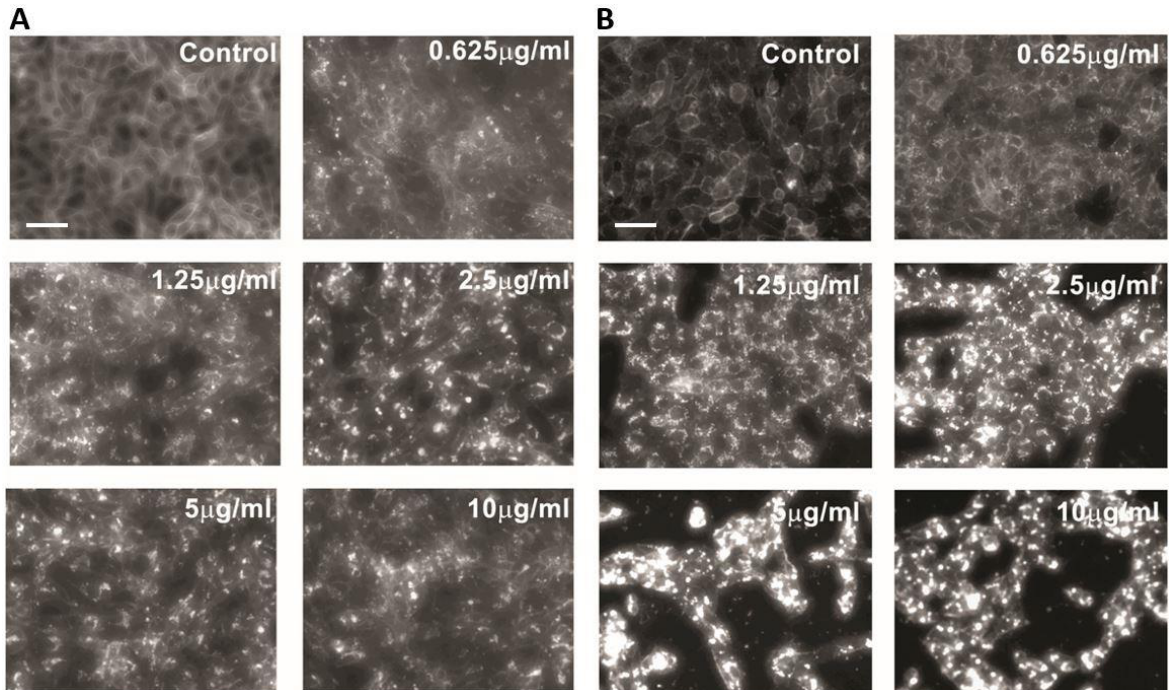
Figure 1. U18666A causes accumulation of intracellular cholesterol. PK-15 ( A ) or Vero ( B ) cells were treated with U18666A (0.625 – 10 μg /mL) or DMSO (0.1%, v / v ) as a vehicle control for 48 h. Unesterified (free) cholesterol was detected by staining with filipin. Data are representative of three independent experiments. Scale bar = 50 µm.